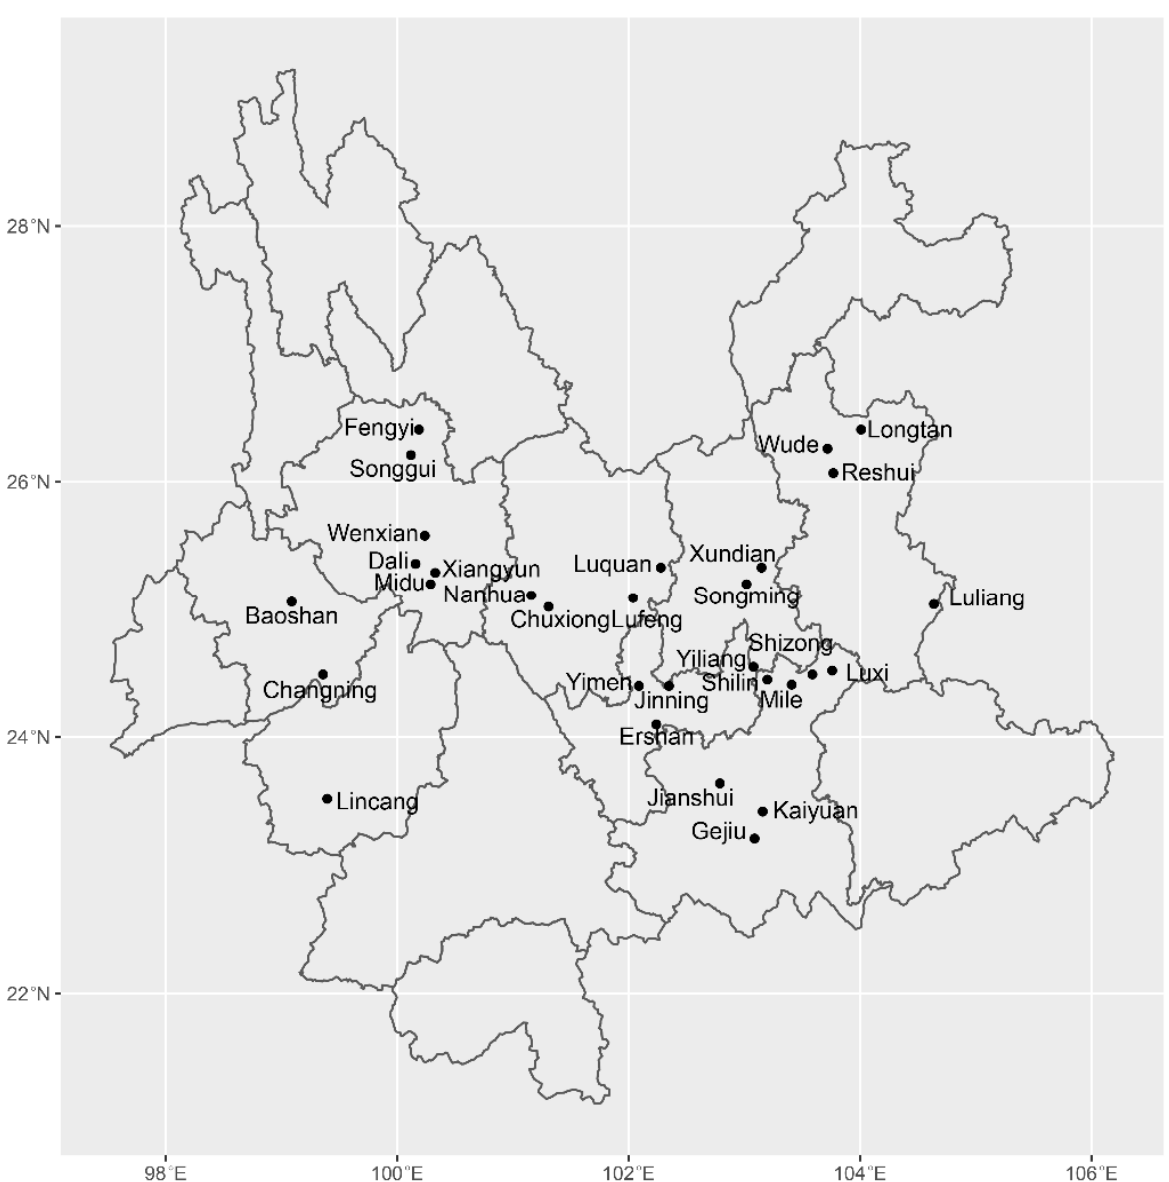
Figure 1. Geographical distribution of Thelephora ganbajun samples collected from Yunnan Province and analyzed in this study. Note: the full names of the sampling sites are indicated in Table 1.